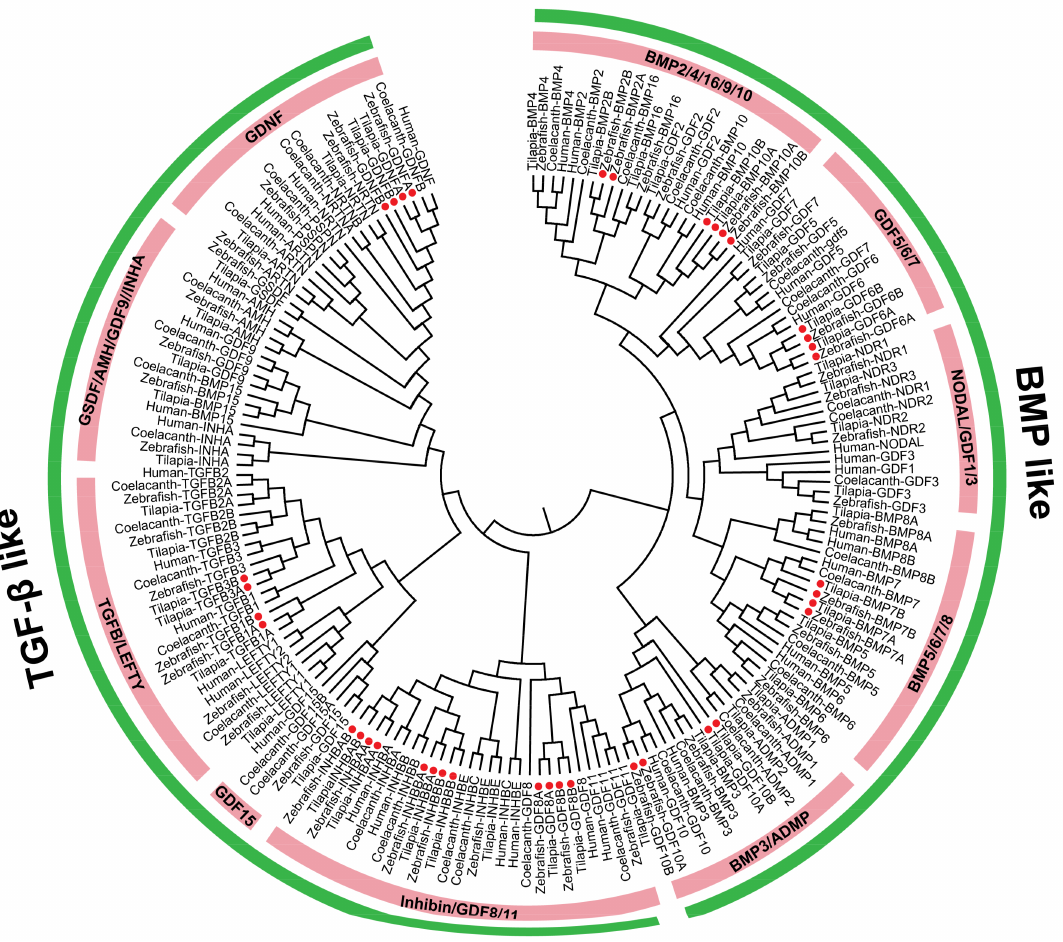
Figure 2. Phylogenetic tree of TGF- β ligands from tilapia, zebrafish, coelacanth, and human. The TGF- β ligands were clustered into TGF- β -like and BMP-like clades, with each clade can be subdivided into many different small groups. The ML method was used to construct the tree by MEGA 6.0 software. The amino acid sequences of TGF- β peptide domains were aligned using the multiple alignment software Bioedit. Red dots indicate genes which retained two copies in teleosts after 3R events. GenBank accession numbers of the sequences used are listed in Table